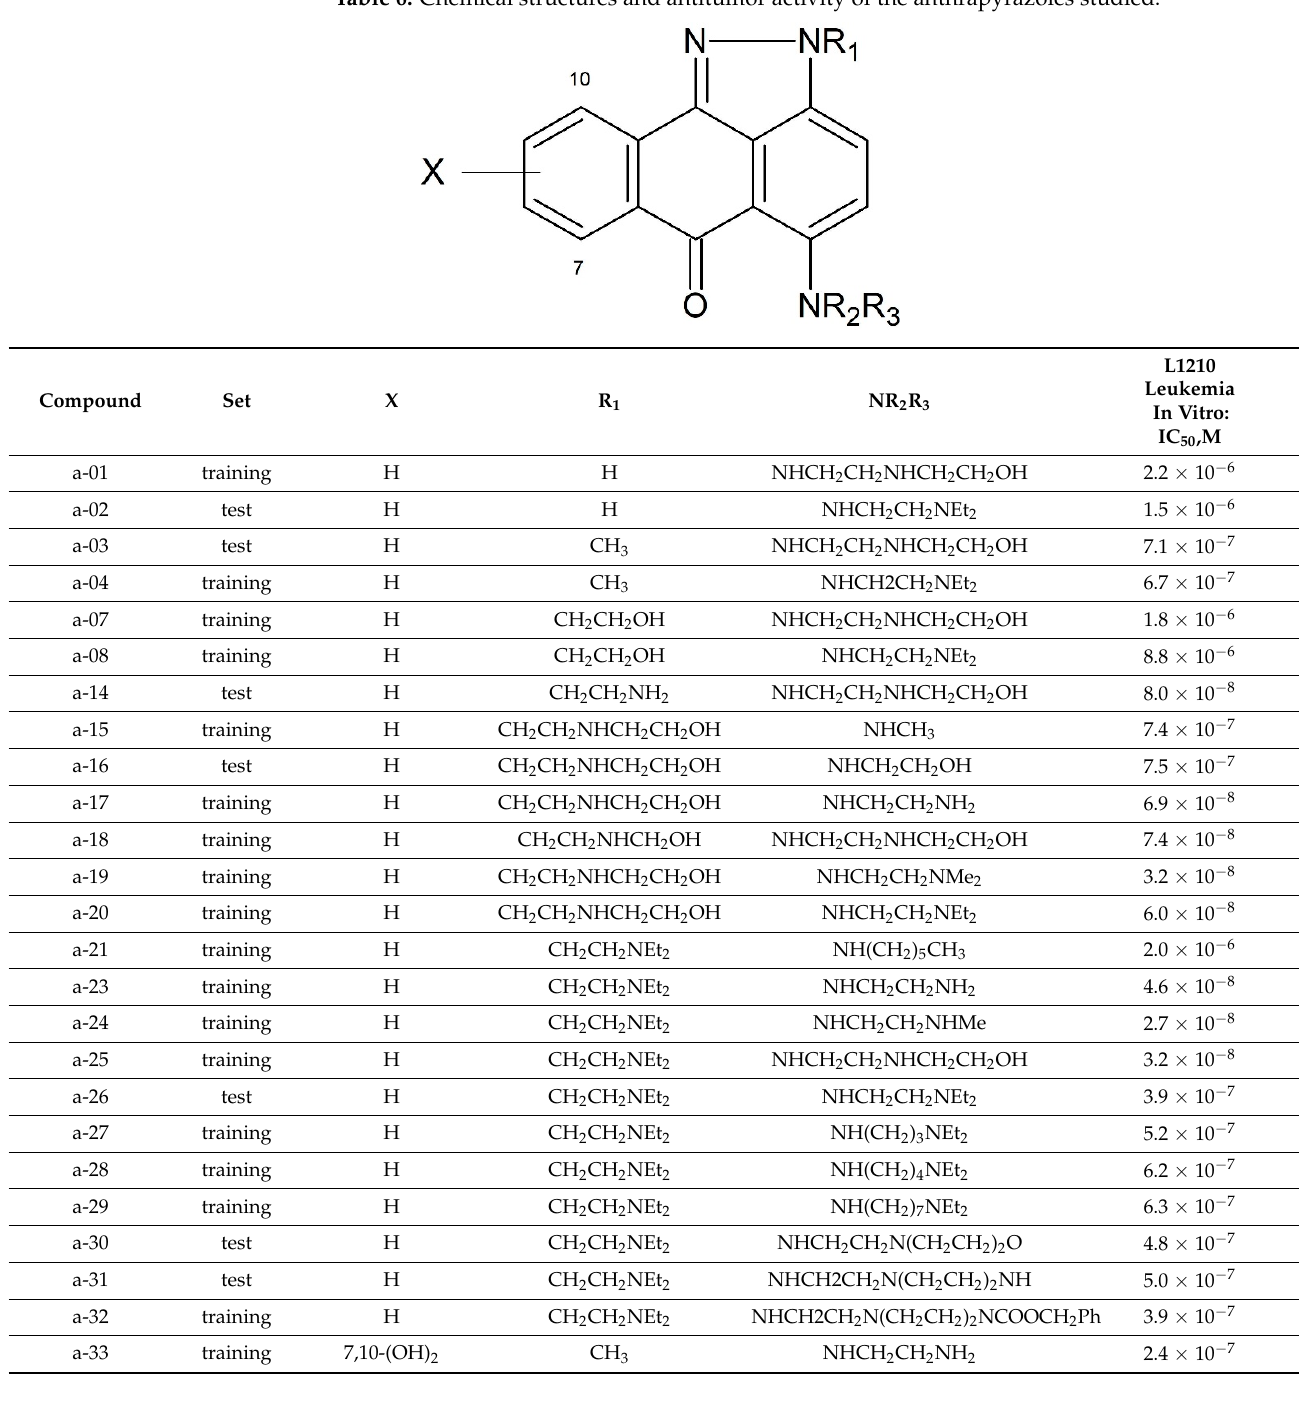
Table 6. Chemical structures and antitumor activity of the anthrapyrazoles studied.